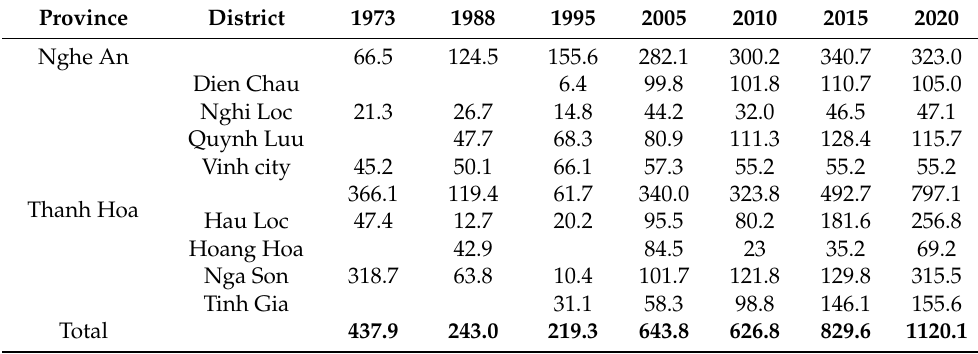
Table 5. The estimated area of mangrove cover (ha) in coastal districts of Nghe An and Thanh